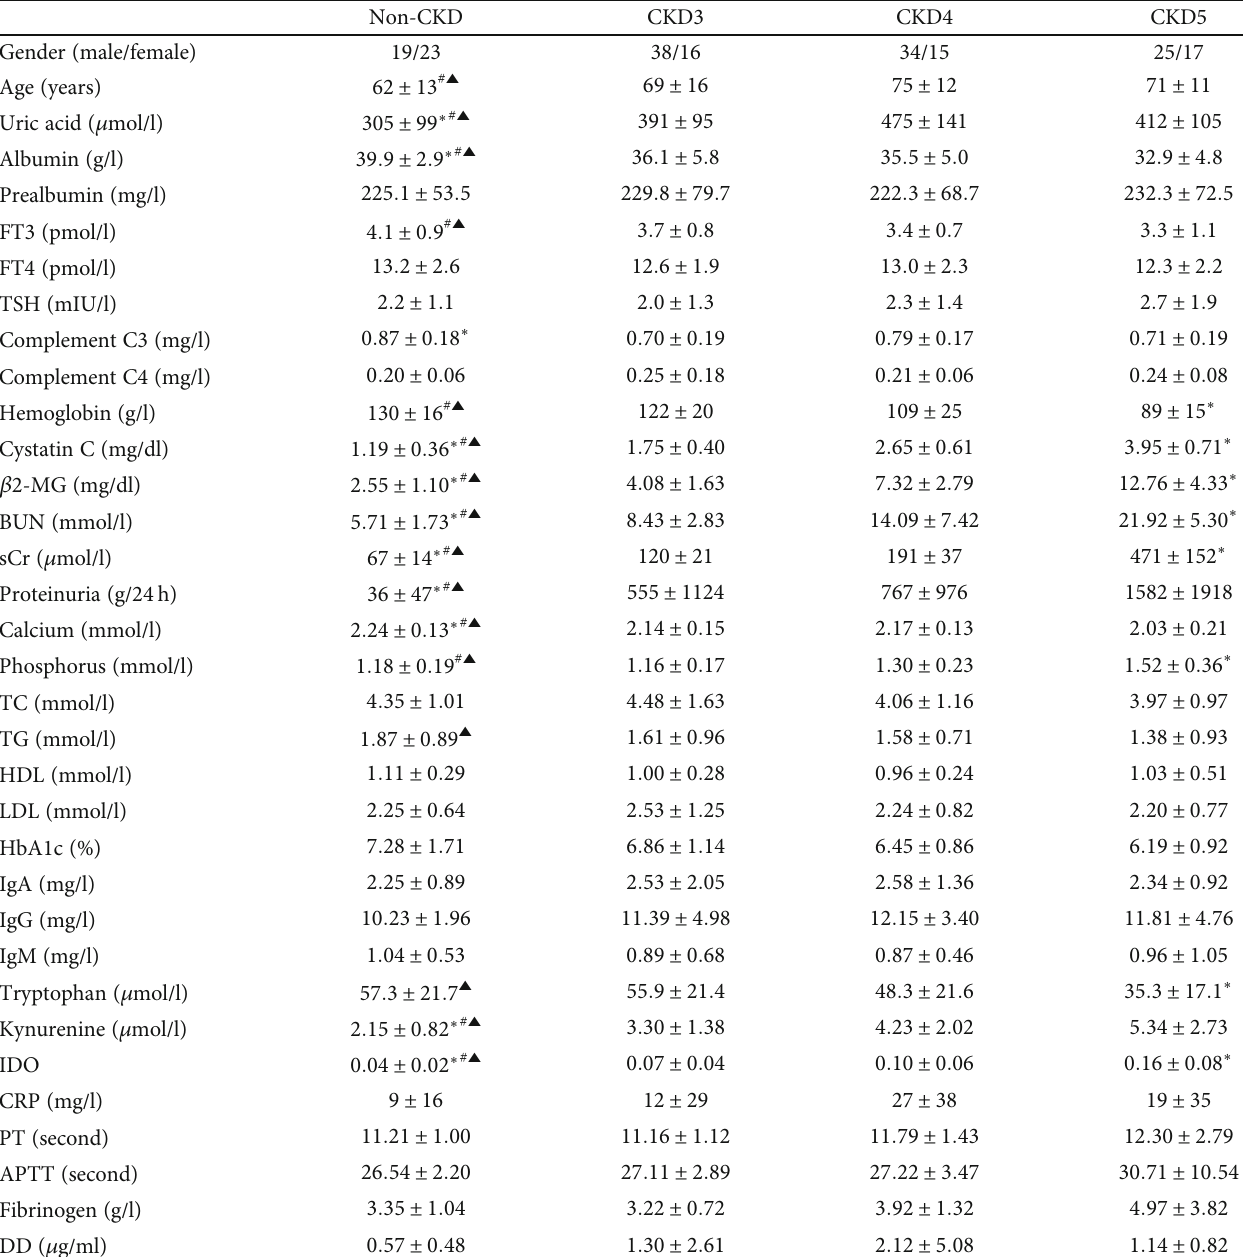
Table 1: Clinical characteristics of CKD patients and non-CKD